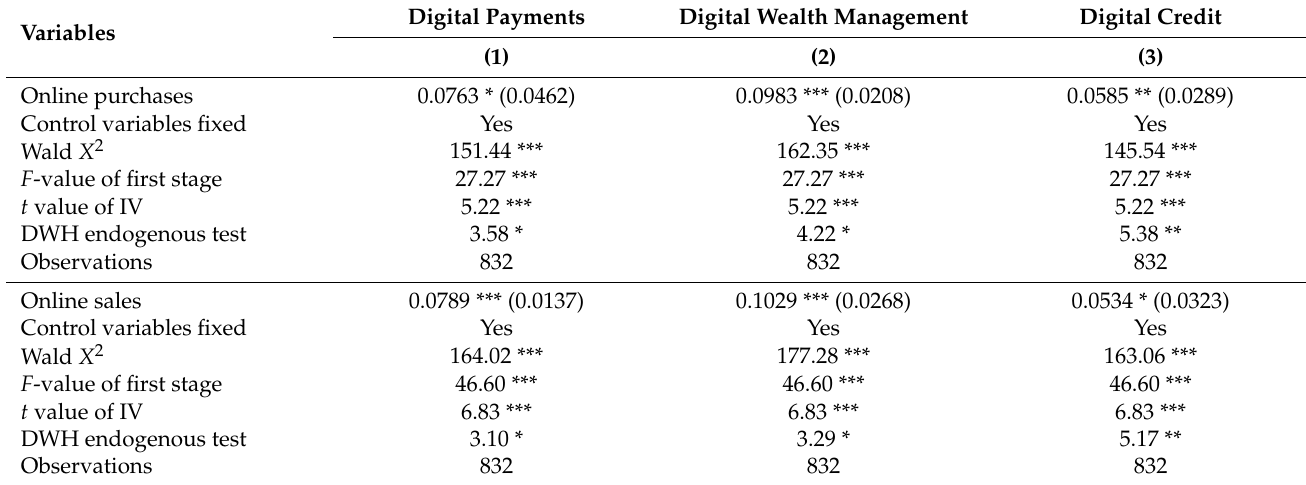
Table 3. IV estimation of the impact of e-commerce adoption on digital finance